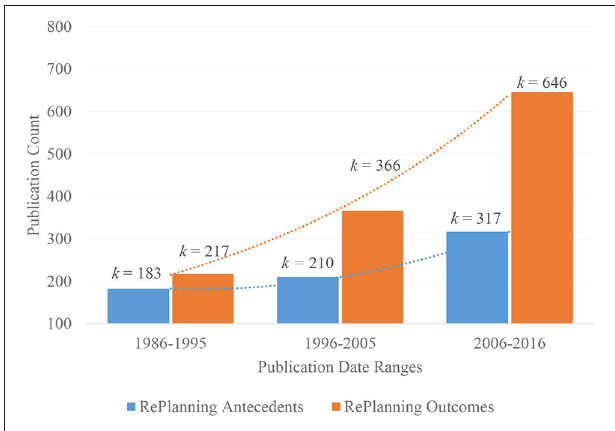
FIGURE 1 | Summary “retirement planning” publication-rate since Beehr (1986) seminal article, separated by “antecedents” and